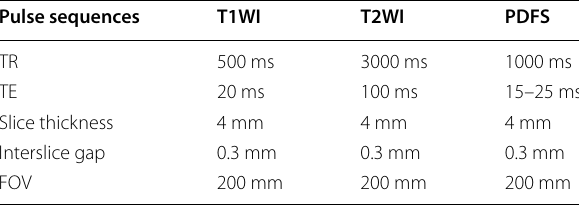
TR repetition time, TE echo time, FOV field of view, PDFS proton density with fat suppression